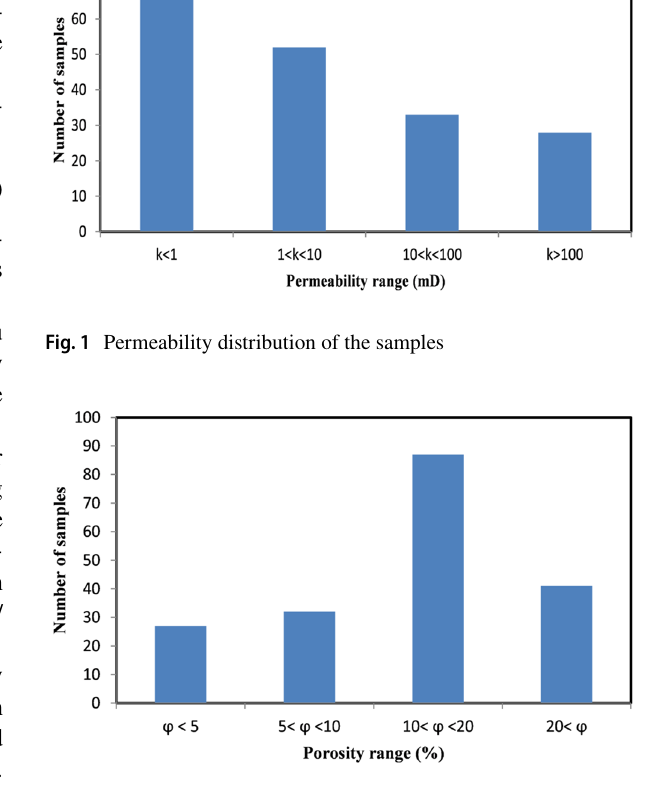
Fig. 2 Porosity distribution of the